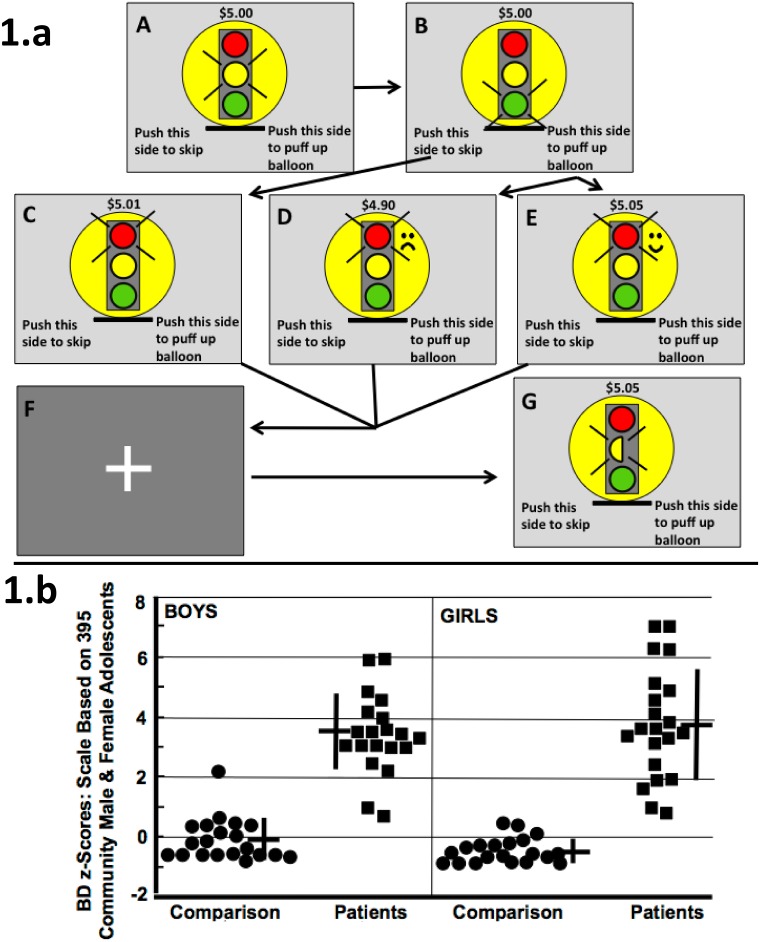
Game; Participants' Behavioral Disinhibition Scores.
(a) Colorado Balloon Game. A: Decision Trial begins, yellow illuminated 4 sec. B: Chosen press executed during 0.5-second green light. Next, red light signals outcome, 3.5 sec. If left press in B, then C (counter increases 1 cent, dull sound, no change in balloon). If right press in B, then either D (counter decreases 10 cents, frowney face, popping sound, balloon shrinks), or E (counter increases 5 cents, smiley face, coin-drop sound, balloon puffs up). F: Fixation screen 2–4 sec. G: Directed Trial begins with 4-sec yellow half-light. Illuminated side (left here) indicates side to press when light turns green. Counter: current earnings. Then, the B-F sequence from the paired Decision Trial follows exactly, but participant knows that "the computer is playing the game now", and that only the counter increase of 2 cents upon the directed press affects participant. (b) 81 Participants’ BD Scores. Crosses: means, standard deviations.